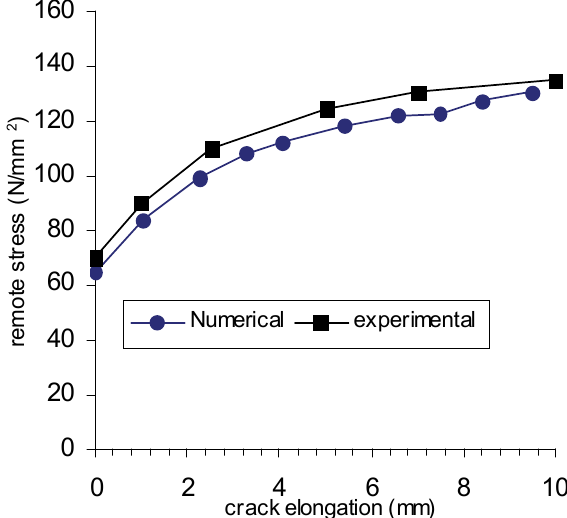
Figure 4: R-curve: numerical-experimental